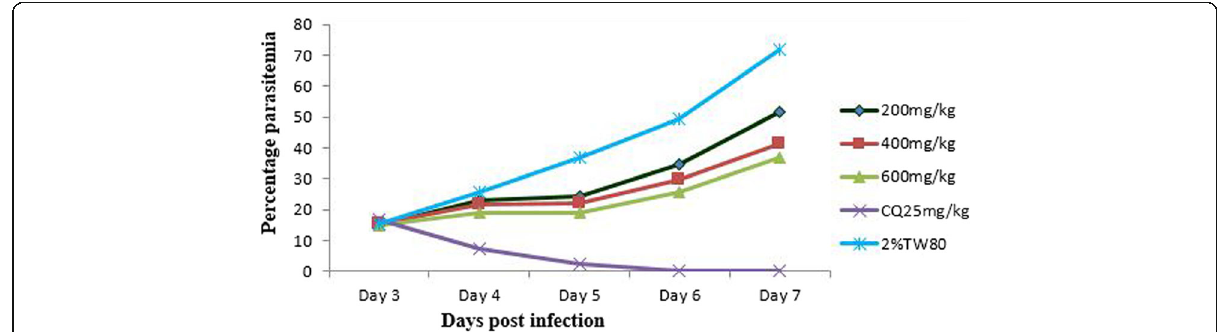
Fig. 1 Parasitemia development over the course of treatment with 80% methanol extract of the leaves of Olea europaea in Rane ’ s